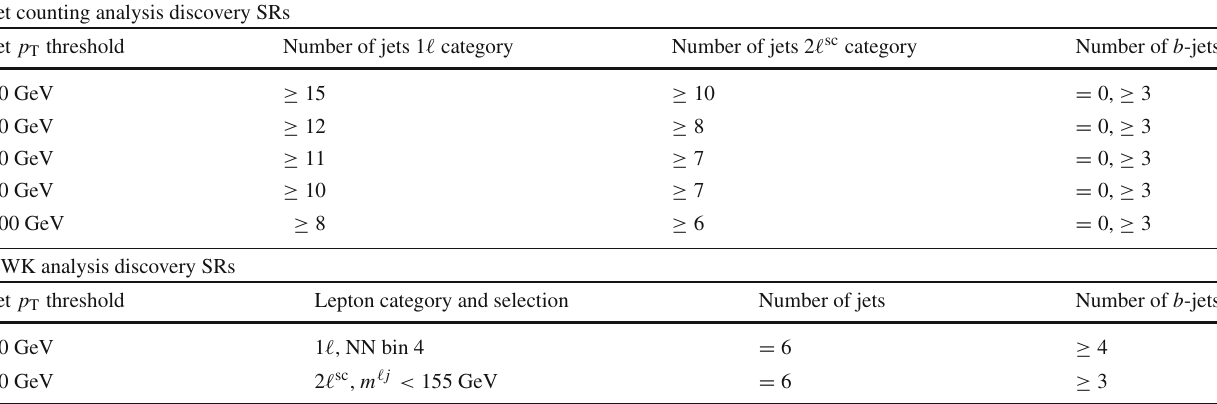
Table4 ThediscoverysignalregionsusedinjetcountingandNNanal- yses, in the search for a generic BSM signal. For every jet p T threshold, four signal regions are defined in the jet counting analysis, leading to